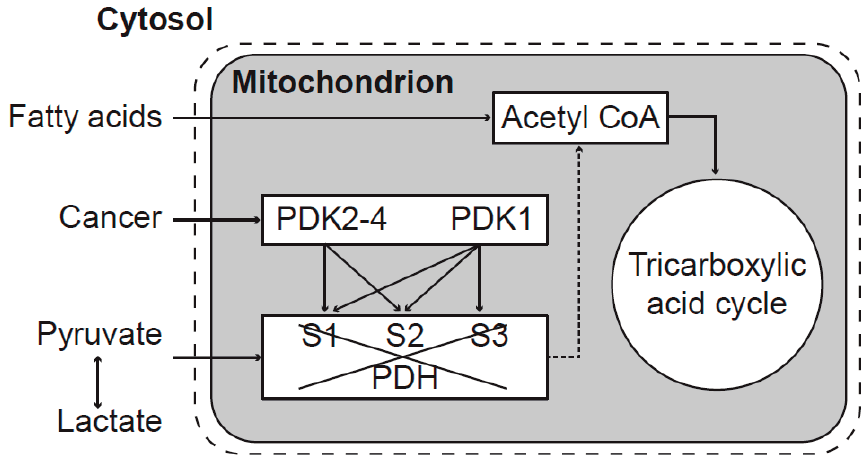
Figure 2. Mitochondrial dysfunction caused by inhibition of pyruvate transfer to mitochondria. The activity of the PDH complex is blocked by PDK enzymes. PDK1 can phosphorylate all three sites—S1, S2, and S3 (Ser-264, Ser-271, and Ser-203, respectively) whereas PDK2, PDK3, and PDK4 each phosphorylate only the sites S1 and S2. After phosphorylation, mitochondrial energy production depends only on fatty acids. Both isoenzymes of pyruvate dehydrogenase phosphatase (PDP1 and PDP2) can reactivate phosphorylated PDH enzymes [27]. Mitochondrial dysfunction transforms chemical changes into biophysical pathological processes along the transformation pathway to